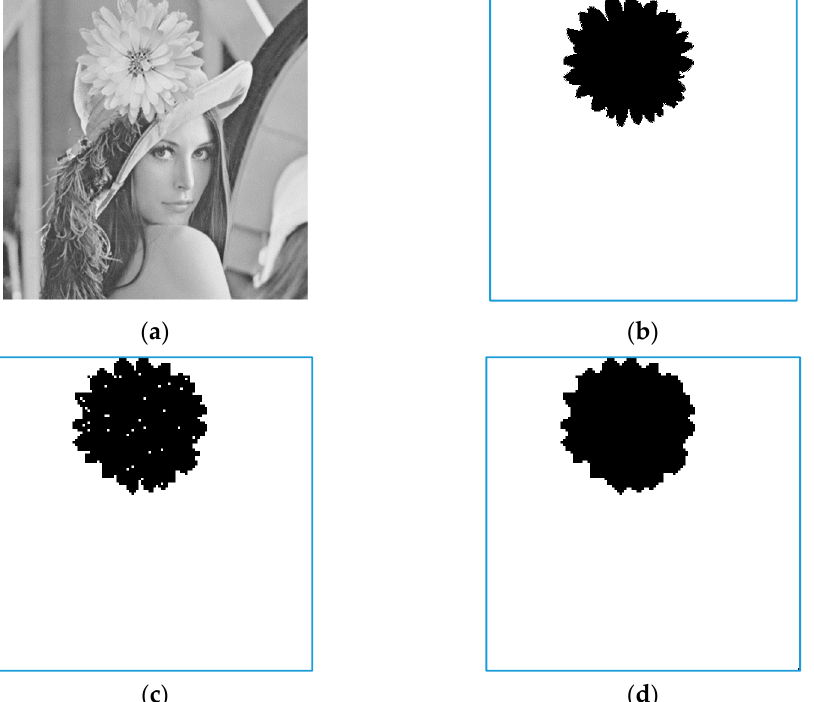
Figure 5. The tampered and detection results. ( a ) The tampered image; ( b ) The tampered region; ( c ) The coarse detection result; ( d ) The refined detection result.